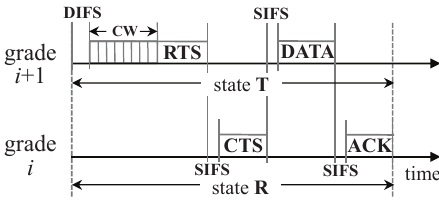
Figure 3. Detailed components of one slot